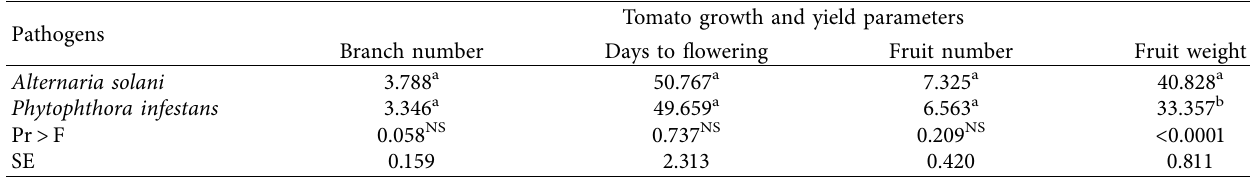
Table 8: Effects of the pathogen on growth and yield parameters of tomato.